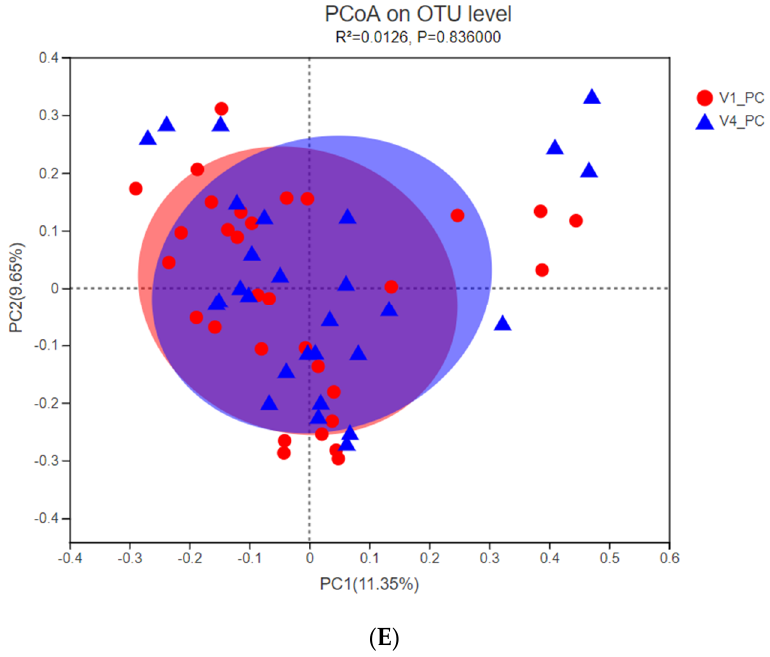
Figure 3. Diversity of the gut microbiota at the operational taxonomic unit (OTU) level. Alpha diversity was evaluated based on the Chao ( A ) and Shannon ( B ). Principal coordinates analysis (PCoA) of the beta diversity was based on the Bray-Curtis. ( C ) Differences between V1 and V4 in the LcS group. ( D ) Differences between V4 in the LcS and placebo groups. ( E ) Differences between V1 and V4 in the placebo group. V1_LCS; samples at V1 in the LcS group, V4_LCS: samples at V4 in the LcS group, V1_PC: samples at V1 in the placebo group, and V4_PC: samples at V4 in the placebo group.